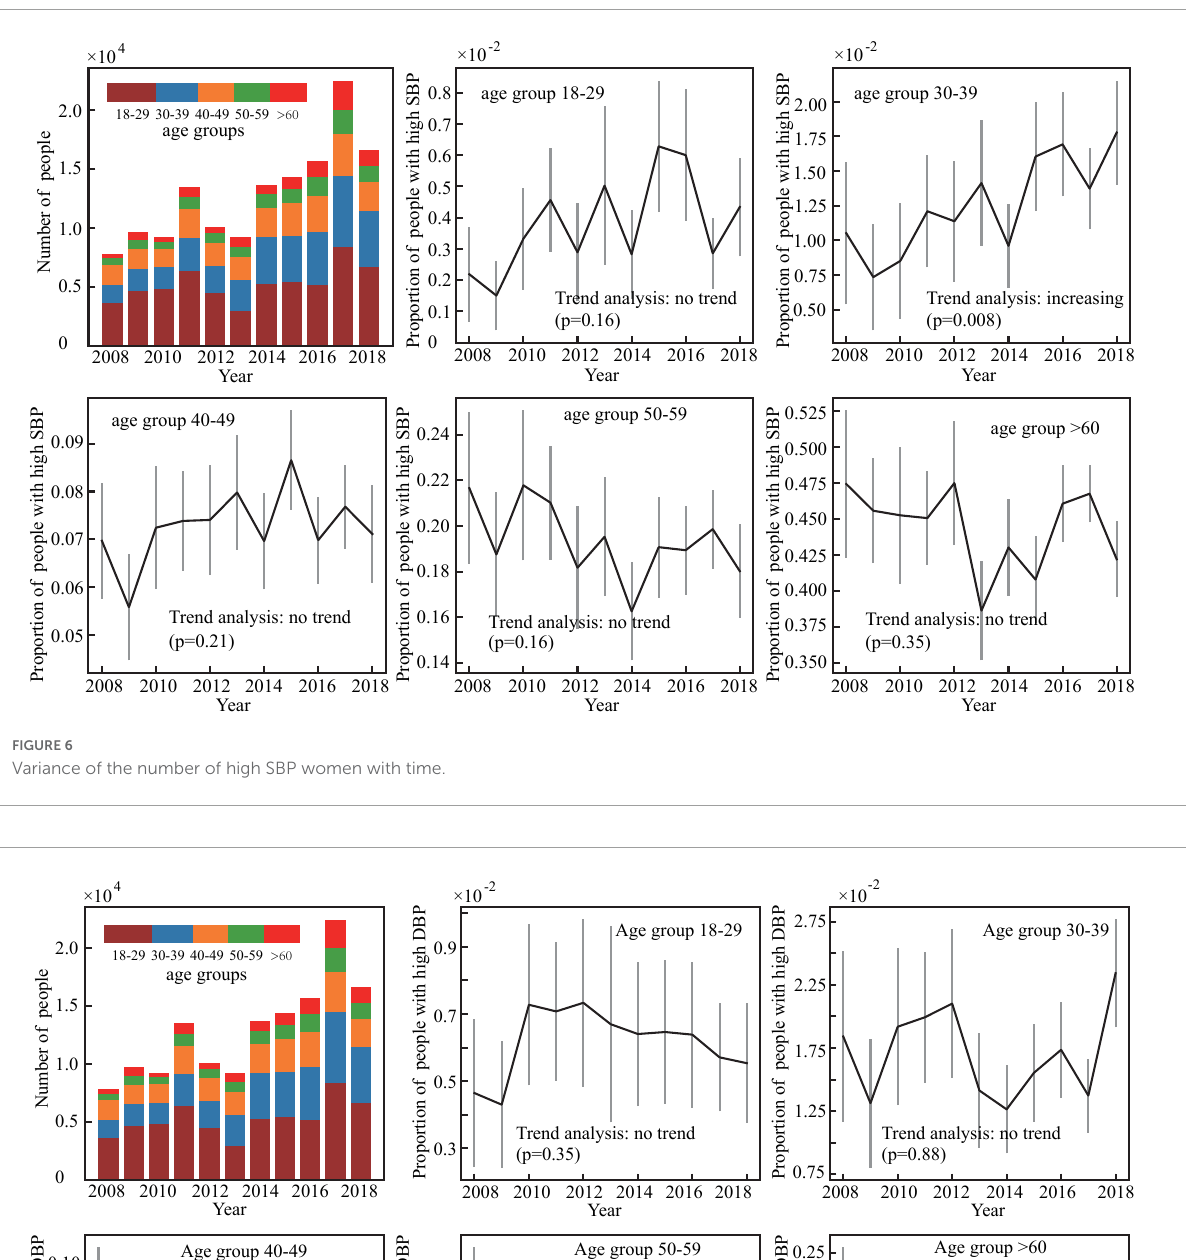
FIGURE7 Variance of the number of high DBP women with